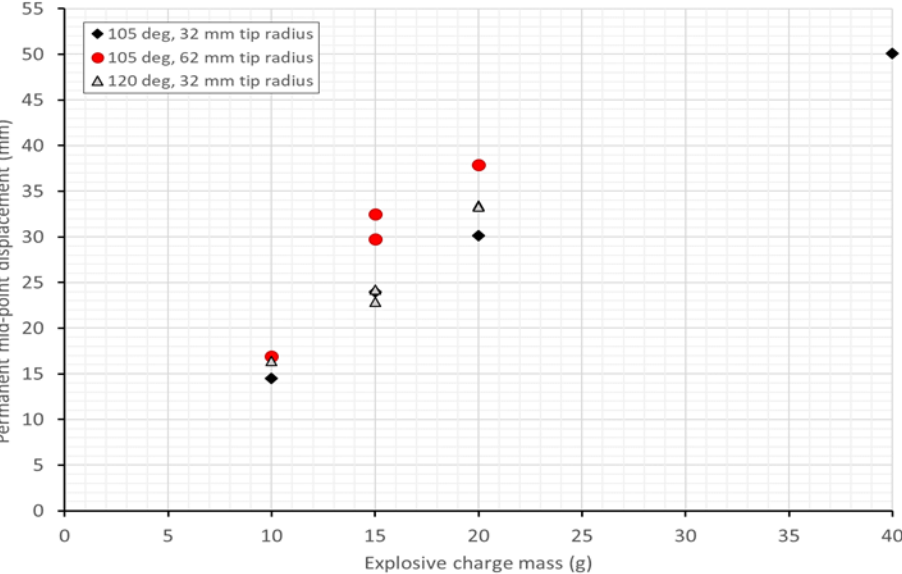
Figure 12. Graph of permanent midpoint displacement vs. charge mass obtained from the blast tests.